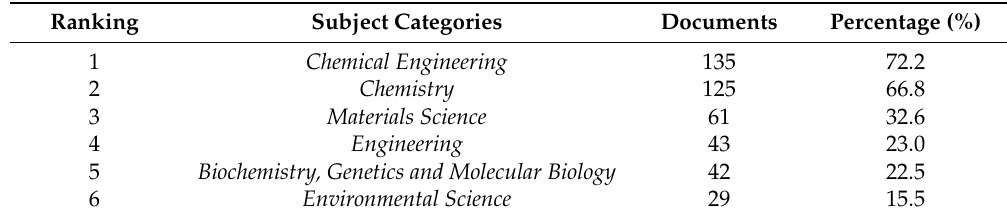
Table 1. The top 6 most popular subject